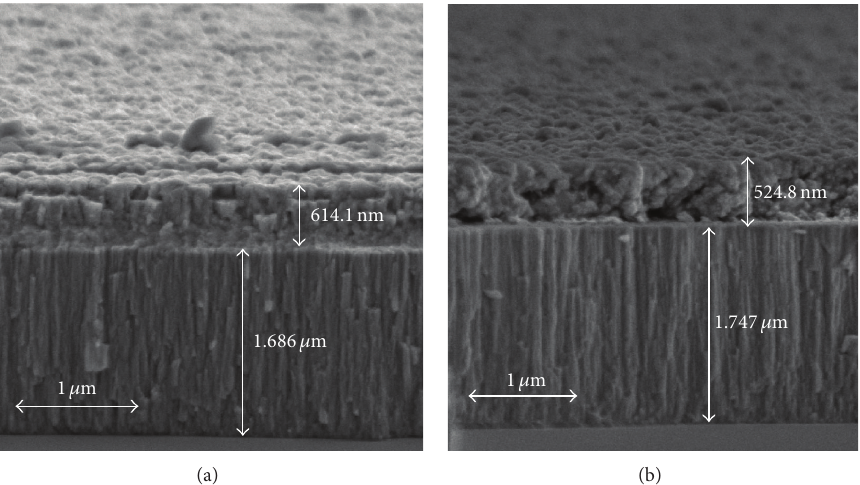
Figure 8: Cross-sectional view of sample A4 (grown at 370 ∘ C) and B4 (annealed and grown at 460 ∘ C) observed by SEM.